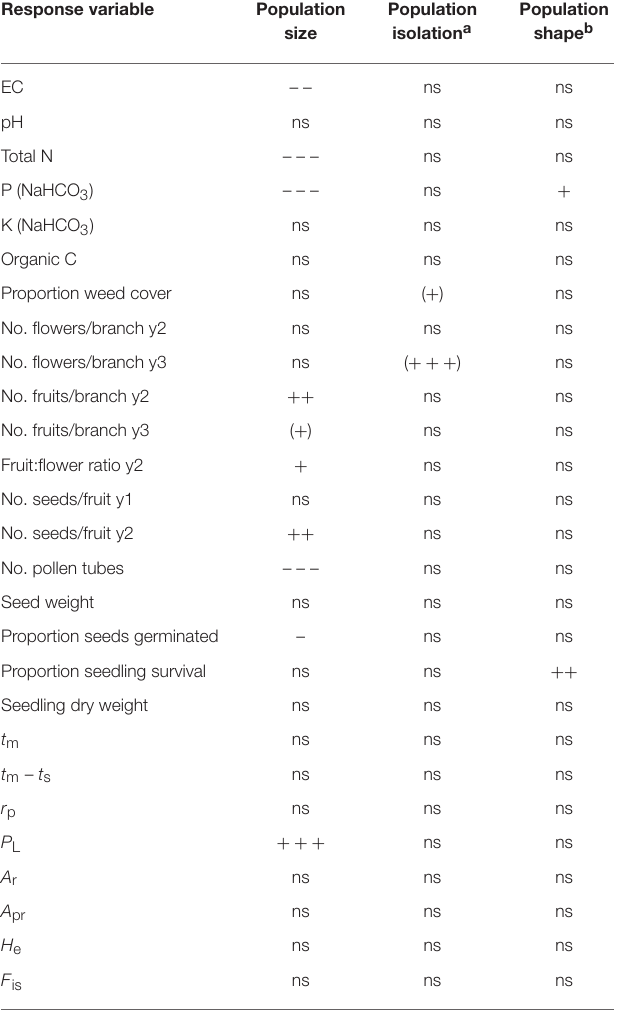
TABLE 2 | Summary of the independent contributions of population size, isolation, and shape to variation in measures of soil chemical properties, weed cover, reproduction, progeny performance, mating system and genetic diversity for 19 populations of Eucalyptus wandoo , determined by hierarchical